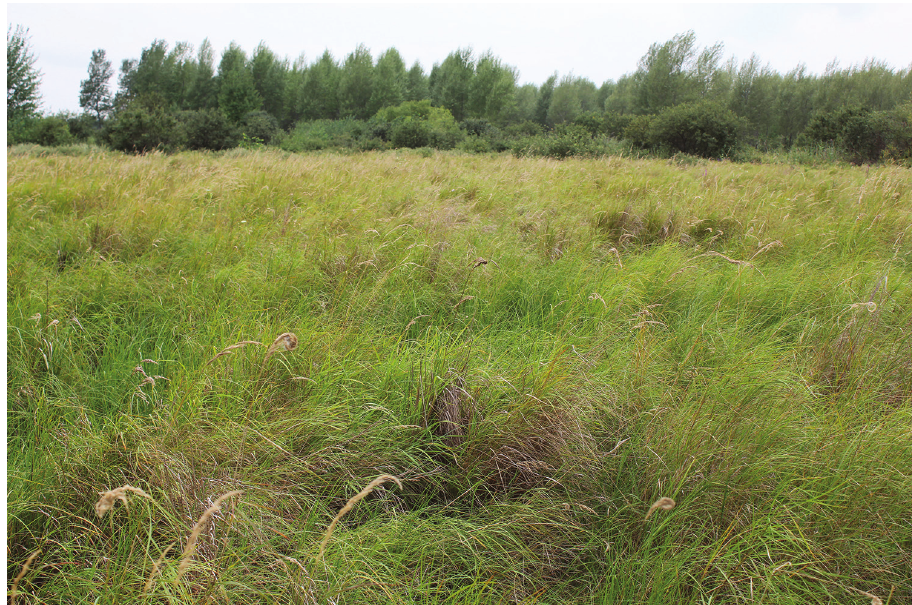
Figure 1. The habitats of Anaphothrips dentatus sp. n. (Photo taken on 9.viii.2012 by Jun